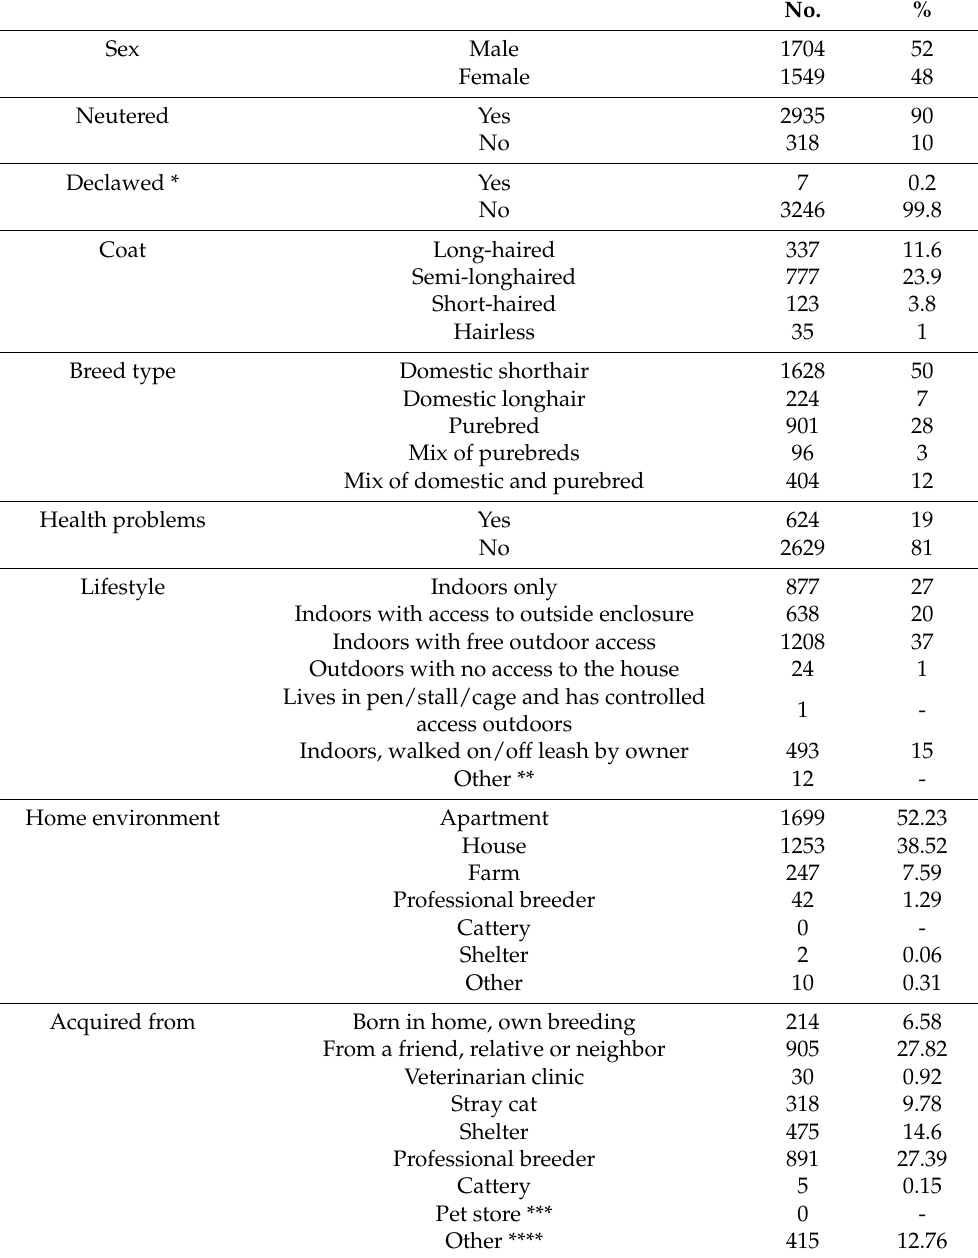
Table 1. A description of the cats involved in this study from the perspective of the